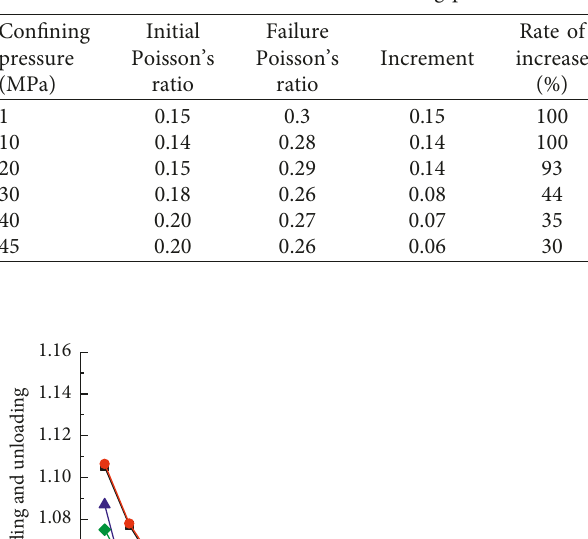
Figure 15: Variation of Poisson’s ratio with cycles. Table 3: Poisson’s ratio of whole loading process.